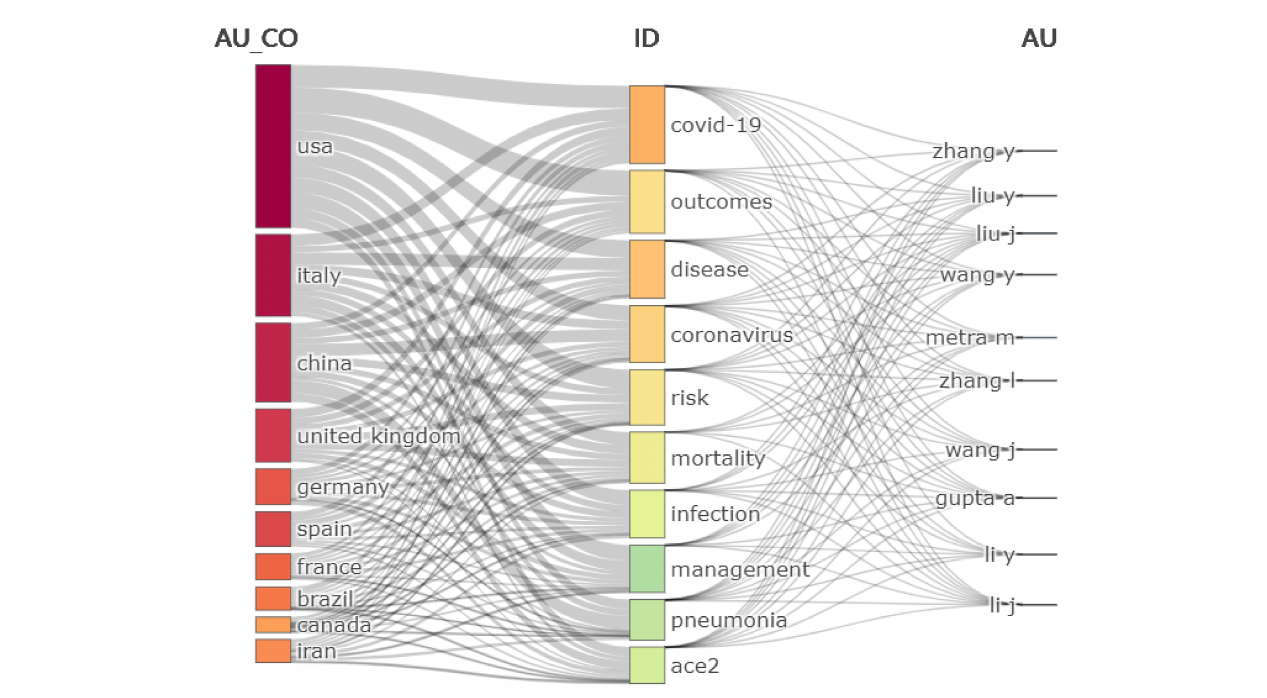
FIGURE1 A three-field plot (Sankey diagram) of the top 10 countries with the most authors, top 10 most-cited keywords, and top 10 most productive authors.